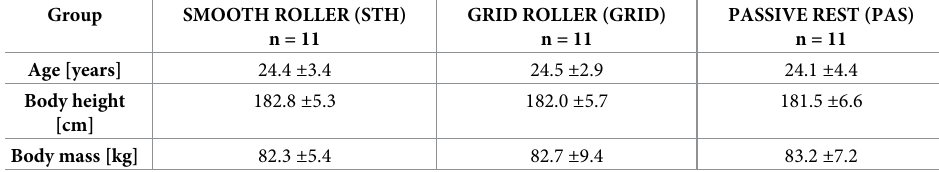
Table 1. Biometric characteristics of the participants divided into groups, mean values ( ±